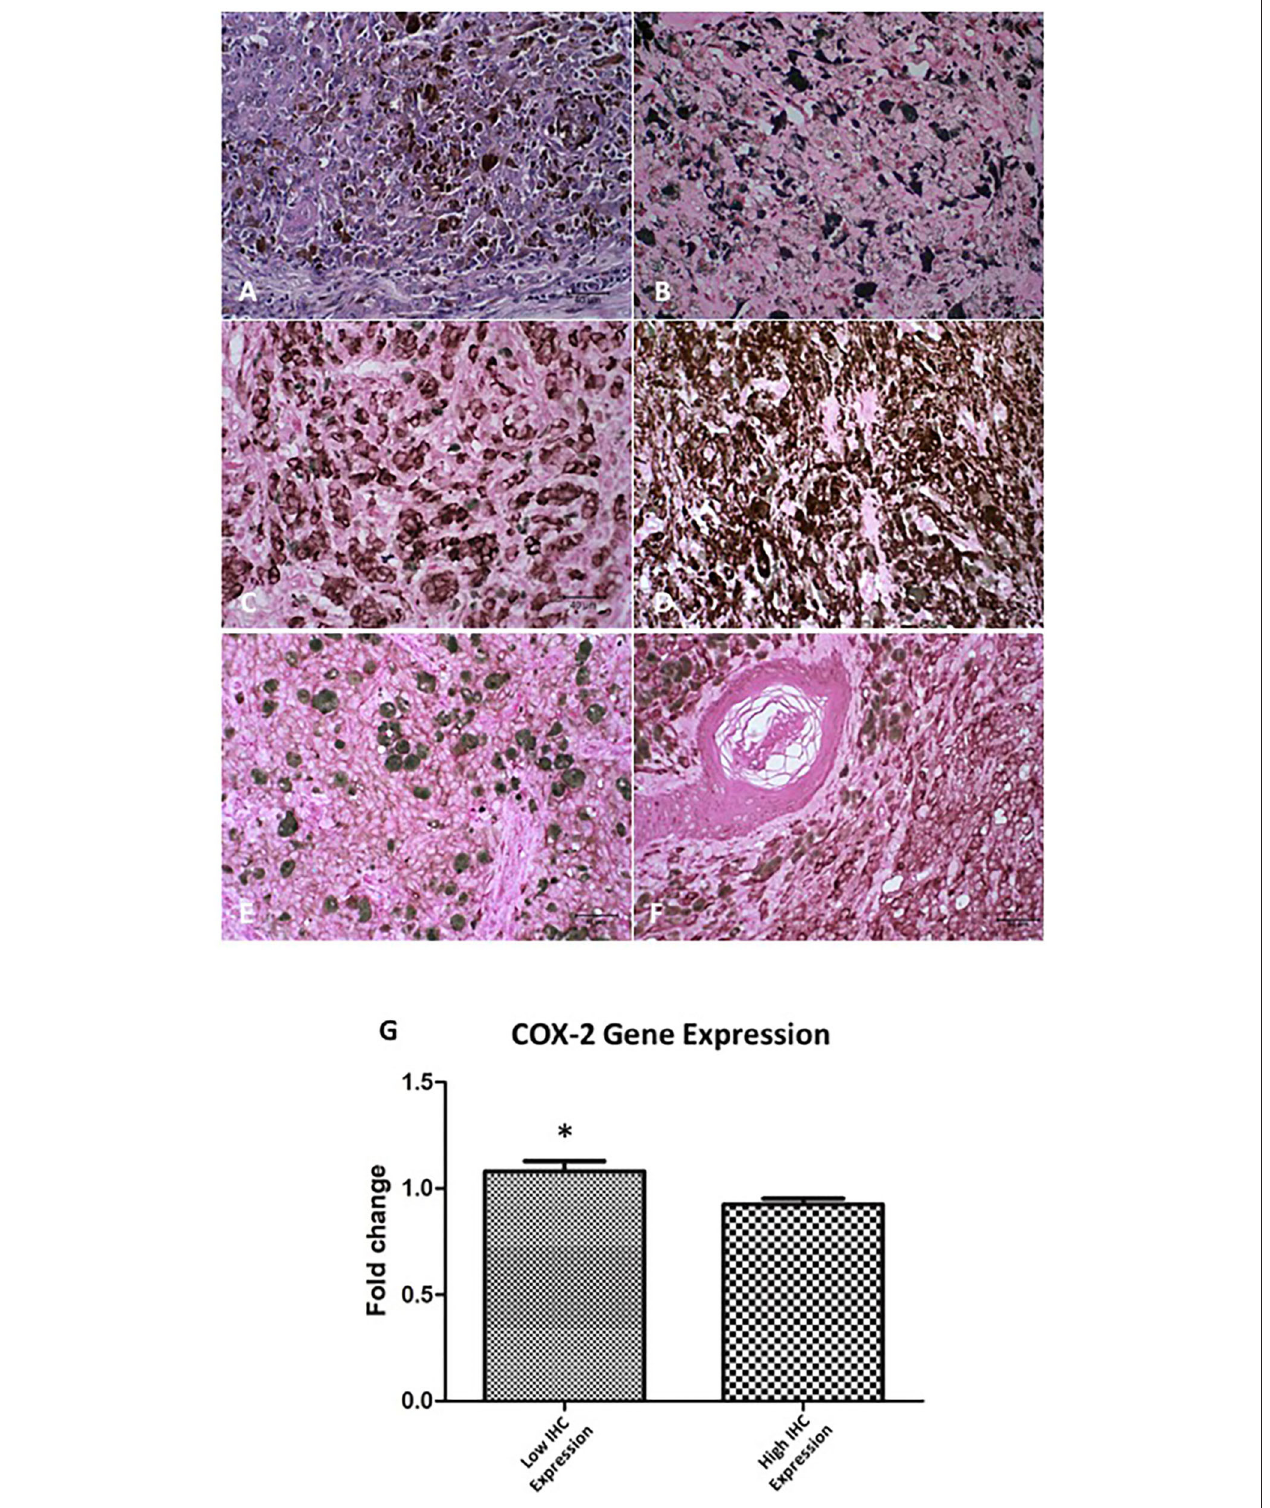
FIGURE 1 | COX-2 expression in oral and skin melanoma in the dog. (A) Oral, mucosal melanoma, no pigmentation. H&E staining. (B) Skin. Ki-67 staining in the nucleus of neoplastic cells. DAB staining of chromogen. Giemsa counterstain. (C) Oral. Melan-A staining in the cytoplasm of neoplastic cells. DAB staining